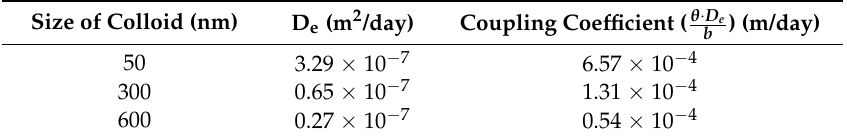
Table 2. Measured coefficient of diffusion and coupling term (3rd term of RHS of Equation (7)) for various colloid